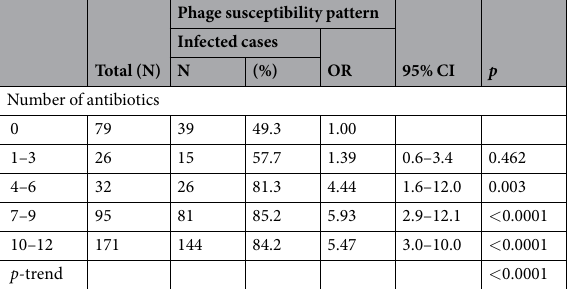
Table 2. Odds ratios (OR) and 95% confidence intervals (CIs) of the phage infection ratio according to the number of antibiotics to which the clinically isolated A. baumannii were resistant. OR and 95% CI values were estimated using binary logistic regression model. The p -trend was calculated using the continuous scale of the number of resistant antibiotics in the corresponding